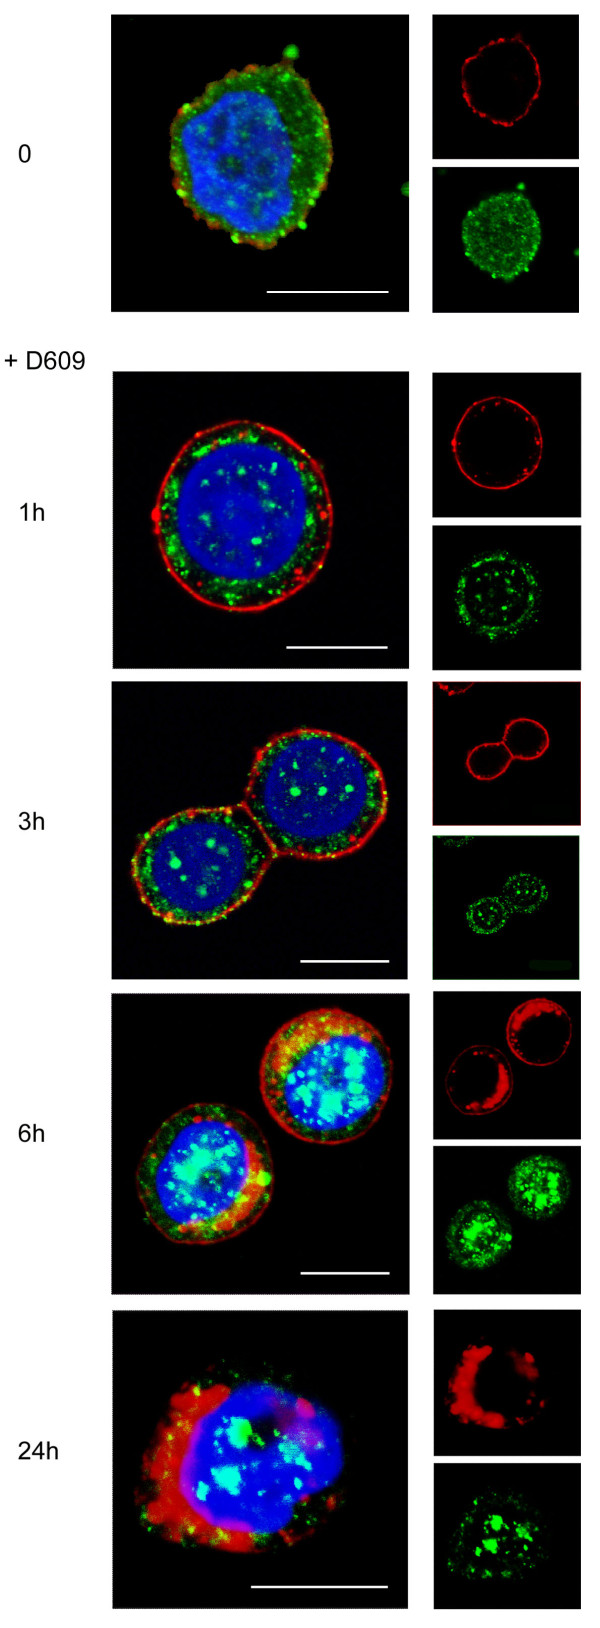
Effect of PC-PLC inhibition on HER2 internalization in SKBr3 cells. CLSM analyses of SKBr3 cells cultured in complete medium either in the absence (t = 0) or presence of D609 (50 μg/mL) for the indicated incubation times. After washing, cells were fixed and stained with α-PC-PLC (green) and α-HER2 Abs (red). Nuclei were stained with DAPI (blue). Colocalization areas were represented in yellow (merge between green and red) or cyan (merge between green and DAPI). Scale bars, 8 μm. Panels show representative examples of five independent series of experiments.